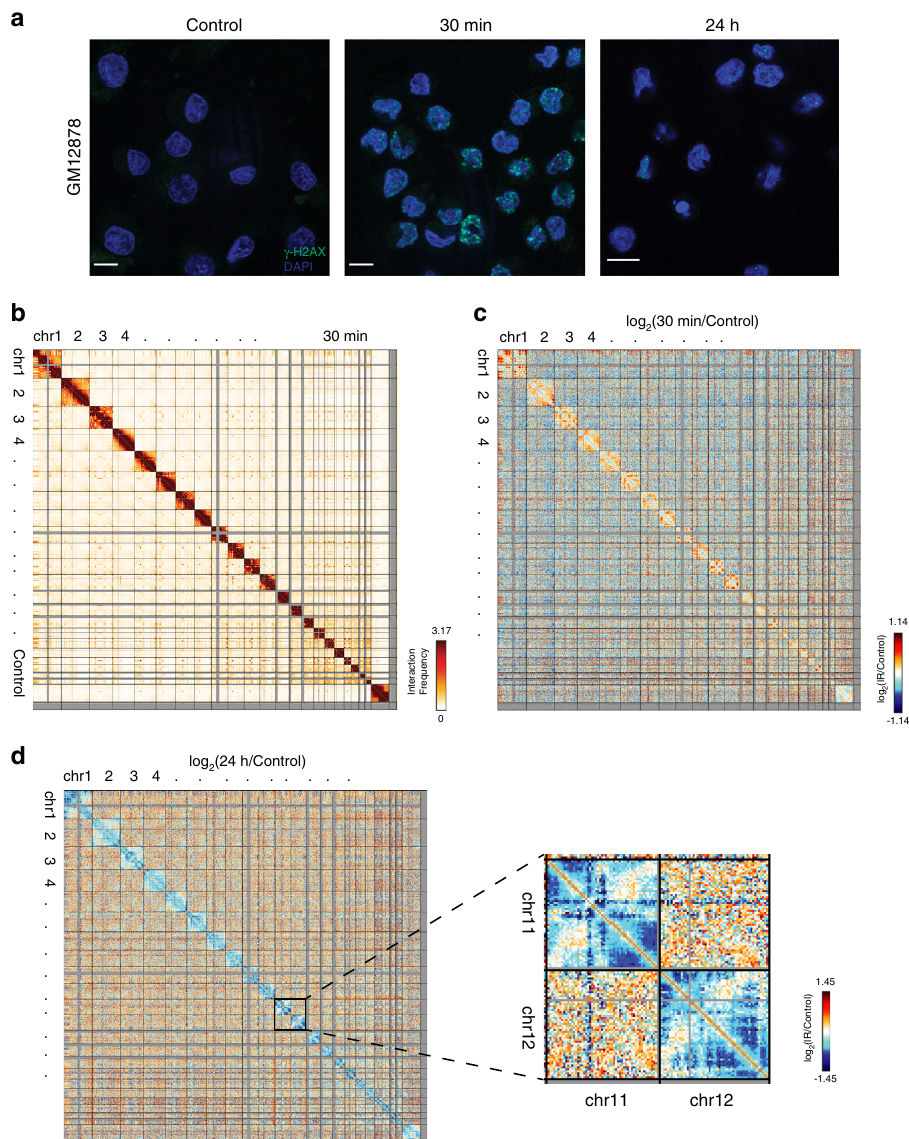
Fig. 2 GM12878 exhibits more evident changes to genome organization after IR. a GM12878 stained with γ H2AX (green) and DAPI (blue) before or after exposure to 5 Gy X-rays. Scale bar: 10 μ m. b Genome-wide contact heatmap of GM12878 in nonirradiated (left) or 30 min after IR (right) in 2.5 Mb bins. c log2(30 min post-IR/Control) contact heatmap in 2.5 Mb bins. d log2(24 h post-IR/Control) contact heatmap in 2.5 Mb bins. Inset reveals example patterns of intrachromosomal interactions that are lost after exposure to